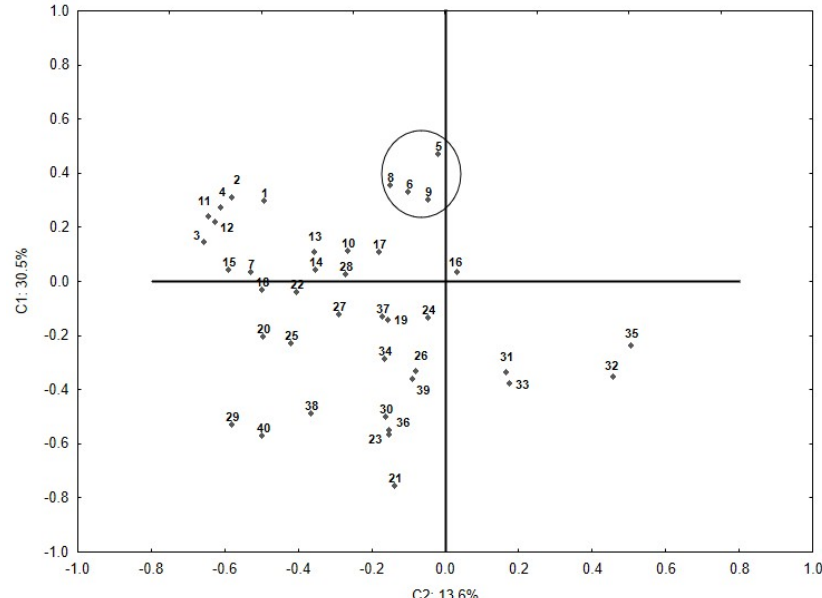
Figure 4. Principal component analyses (PCA) used to display variation between statistically sig- nificant determined VOCs, where: 1. cyclohexanone; 2. 3-ethylcyclopentanone; 3. 3-hexanone; 4. 3-heptanone; 5. methyl hexadecanoate; 6. 9-hexadecen-1-ol; 7. 3-methyl-2-pentanone; 8. 6,10-